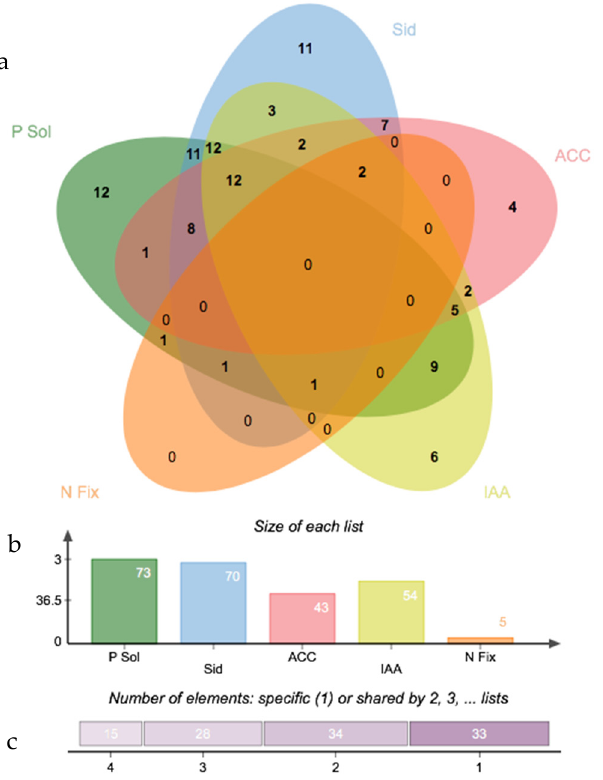
Figure 6. Number of isolates expressing different plant-growth promoting traits ( a ); number of isolates displaying each plant-growth promoting trait ( b ); number of isolates combining the expression of 1, 2, 3, 4, 5 or 6 plant-growth promoting traits ( c ).